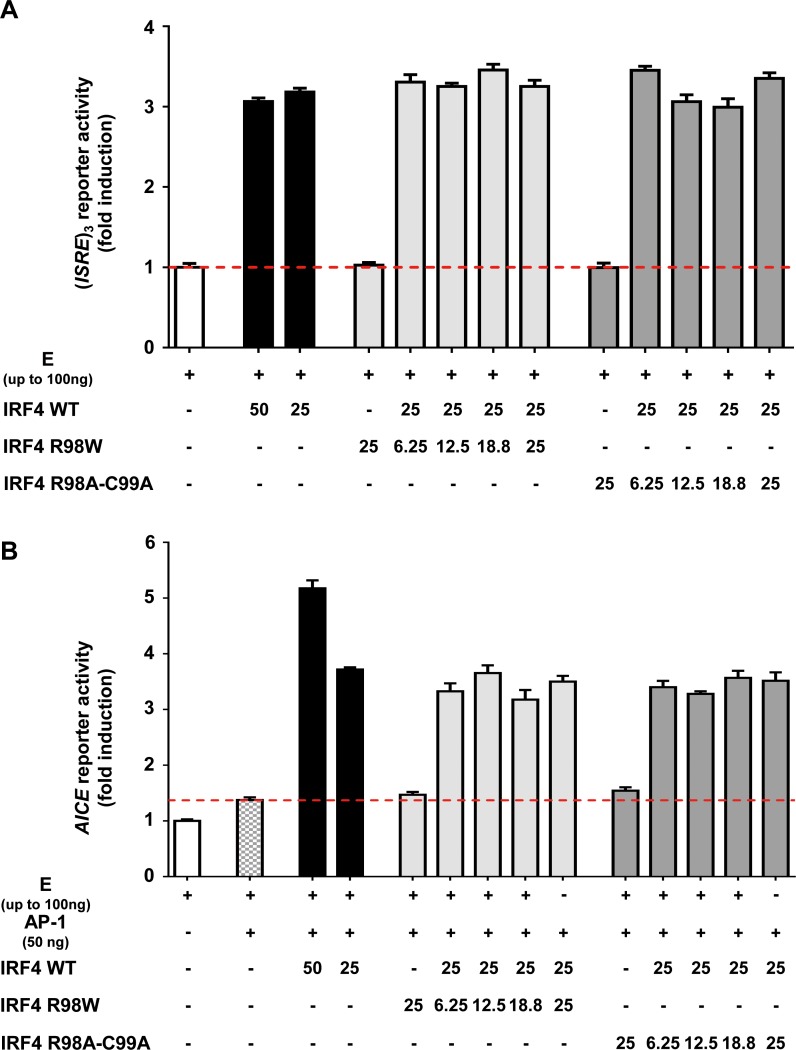
Functional activity of IRF4. (A) Luciferase activity of HEK293T cells cotransfected with an (ISRE)3 reporter plasmid plus the pcDNA3.1 empty vector (E) and plasmids encoding IRF4 WT and/or IRF4 R98W or IRF4 R98A/C99A. The amount of plasmid used for transfection (ng) is indicated on the figure. Results are showed as fold induction of activity relative to E-transfected cells. The red dotted line represents the mean activity for E-transfected cells. The mean and standard error of three experiments are shown. (B) Luciferase activity of HEK293T cells cotransfected with an AICE reporter plasmid plus the pcDNA3.1 empty vector (E) and/or constant amounts of plasmids encoding BATF WT and JUN WT (25 ng each, AP-1) and/or plasmids encoding IRF4 WT and/or IRF4 R98W or IRF4 R98A/C99A. The amounts of plasmid used for tranfection (ng) are indicated on the figure. Results are shown as the fold induction of activity relative to E-transfected cells. The red dotted line indicates mean activity for AP-1-transfected cells. The mean and standard error of two experiments are shown.